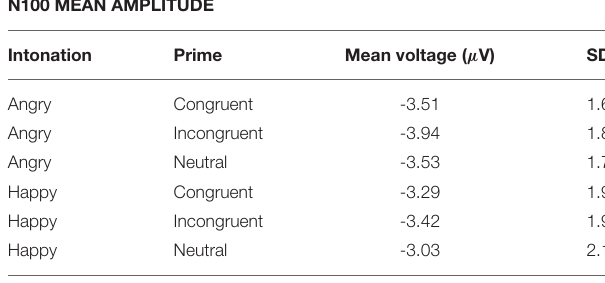
TABLE 1 | ERP amplitude and latency